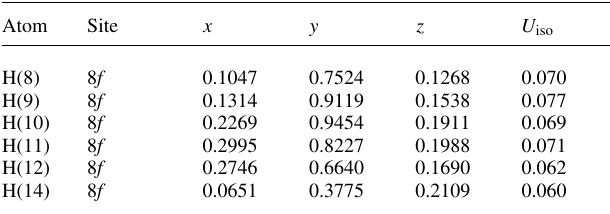
Table 2. Atomic coordinates and displacement parameters (in Å 2 )